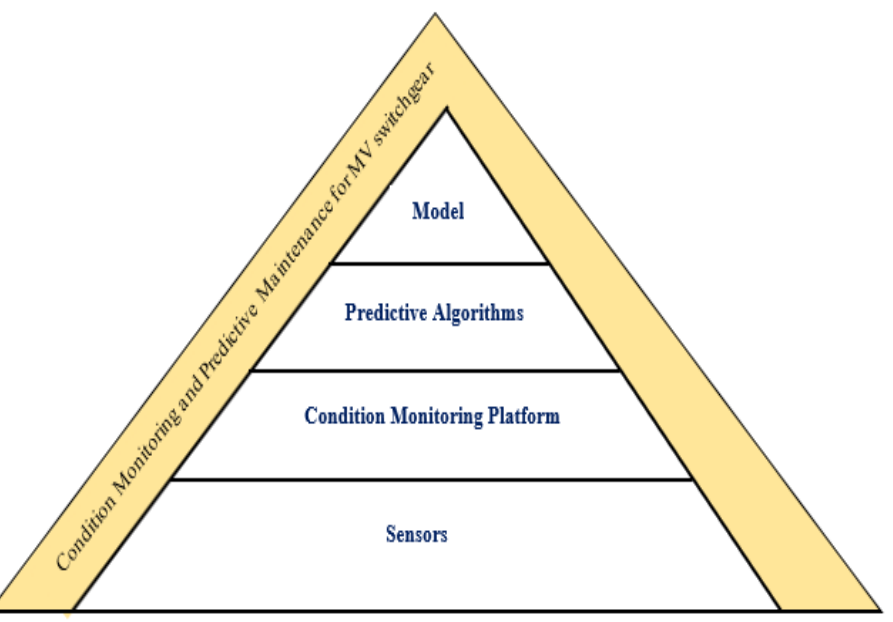
Figure 1. A comprehensive overview of medium-voltage switchgear condition monitoring and preventative analysis.